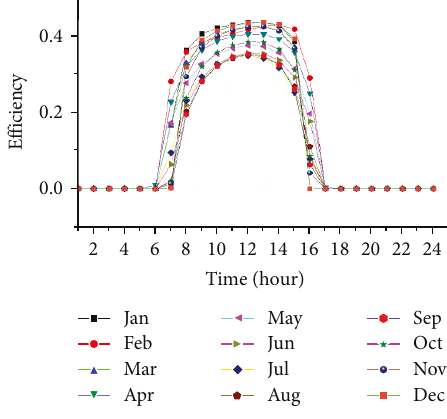
Figure 10: Daily e ffi ciency for di ff erent months.